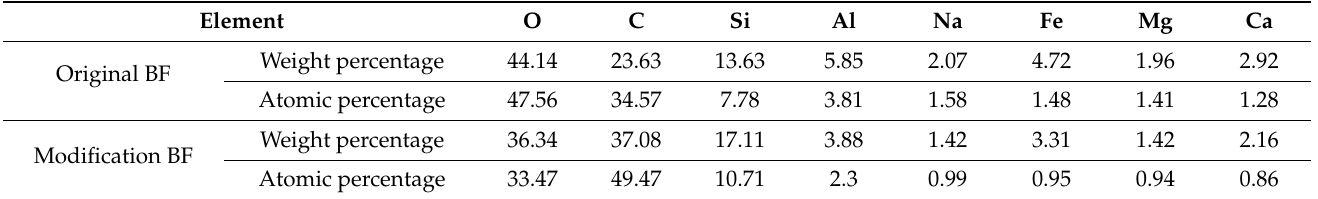
Figure 7. EDS composition analysis of basalt fiber before and after modification: ( a ) original BF; ( b ) coupling modification BF. Table 5. Surface atomic number of basalt fiber before and after modification.